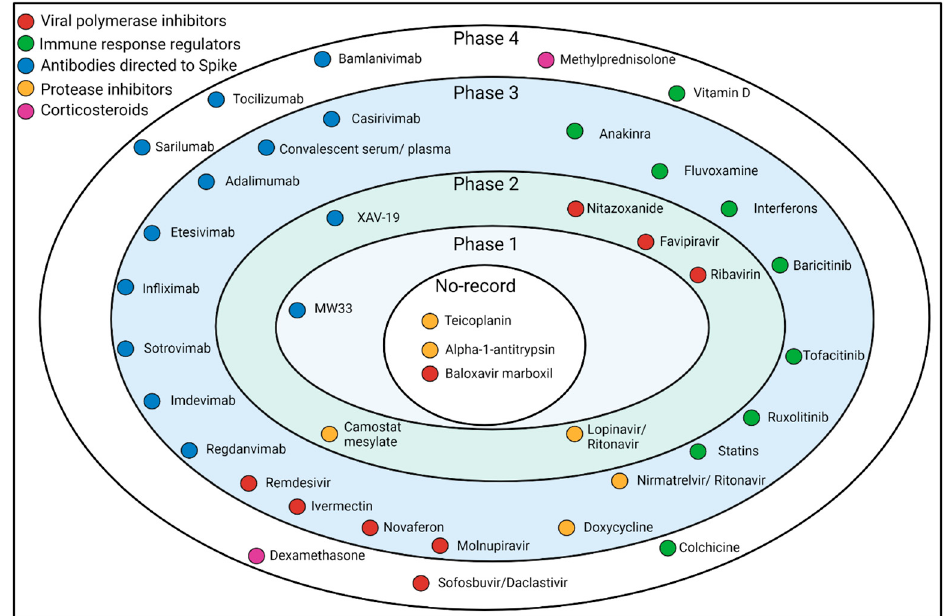
Figure 2. Phases of potential COVID-19 drugs in clinical trials. The main drugs with potential therapeutic use against severe COVID-19 and the clinical trial phases in which they are located are listed.